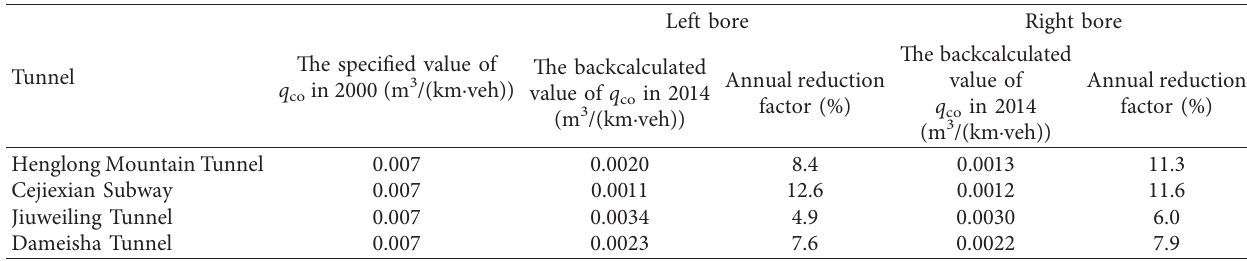
Table 6: The backcalculated reduction rates of CO-based emission factors (60km/h).